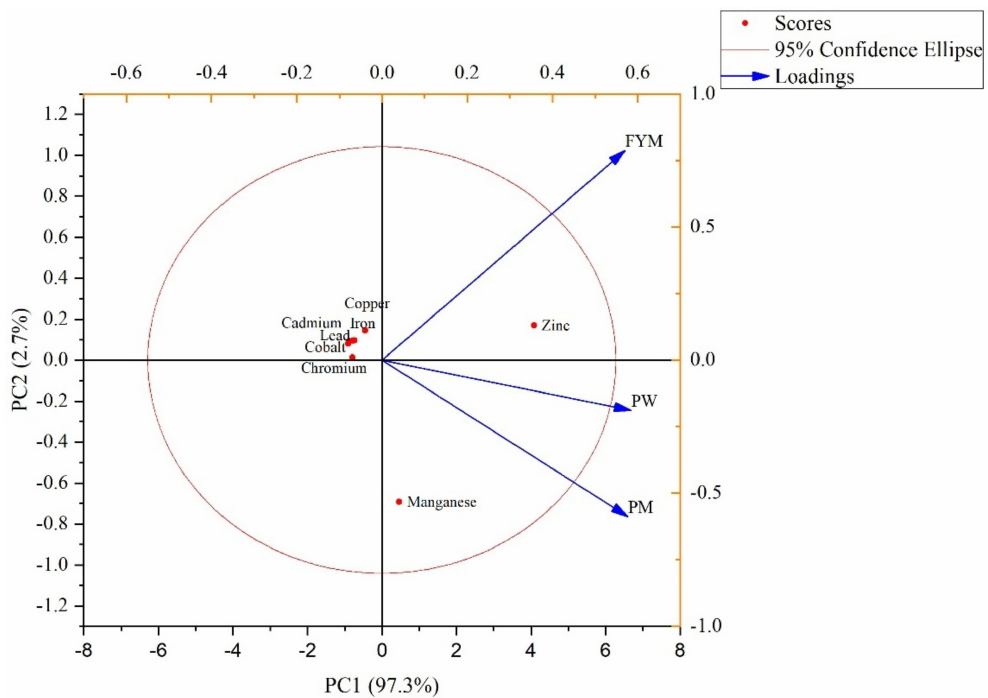
Figure 1. Principal component analysis of mean values of metal accumulated in soil samples. It is a is a combination of score plot of metal ions (represented as dots) and loading plot of treatments (represented as vectors). FYM: farmyard manure, PW: poultry waste, PM: press mud.